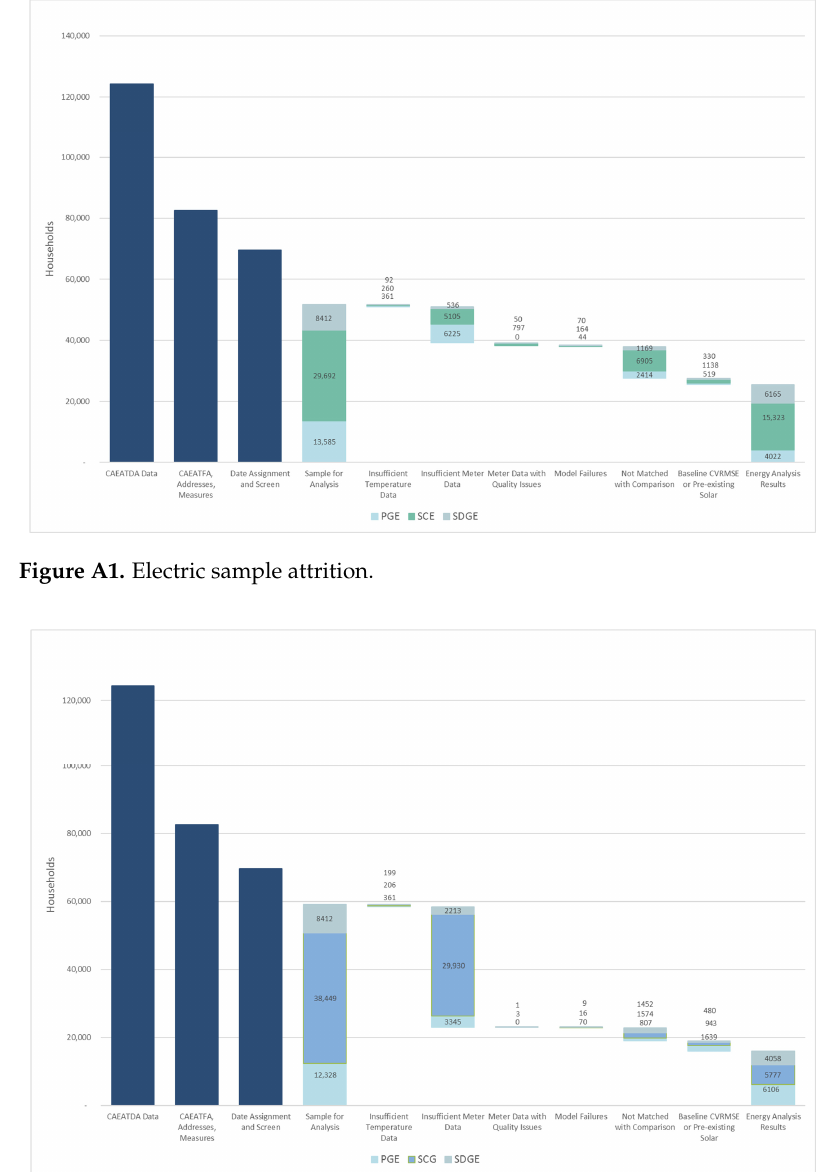
Figure A2. Gas sample